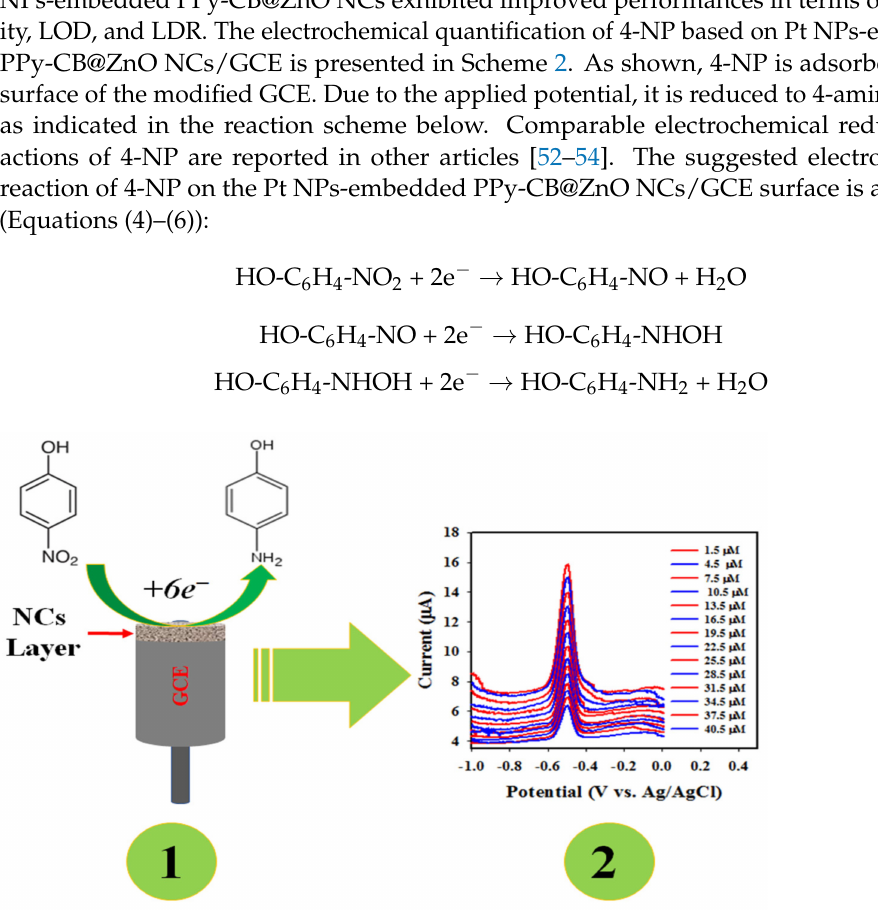
Scheme 2. Schematic representation of chemical sensing; ( 1 ) electrochemical reduction of 4 − NP and ( 2 ) the concentration-based responses of 4 − NP to 4 −